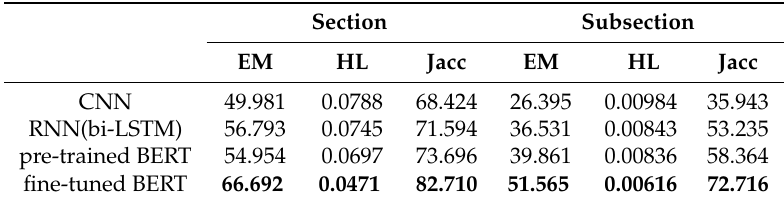
Table 2. Ablation study on P-Block